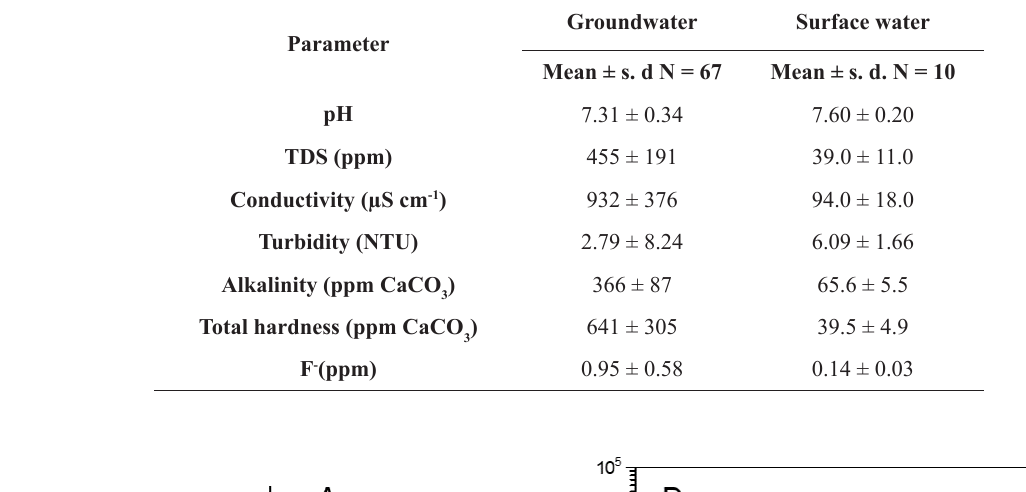
Table 3: Chemical composition of surface and groundwater in Nettiyagama village.